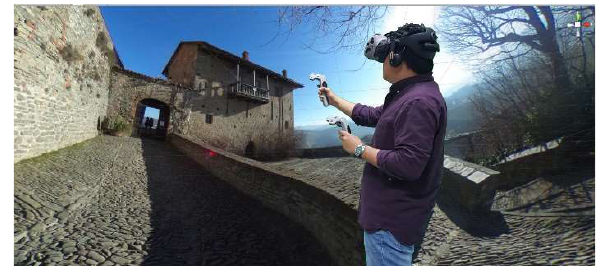
Fig. 13. Player vision into the Hotspot